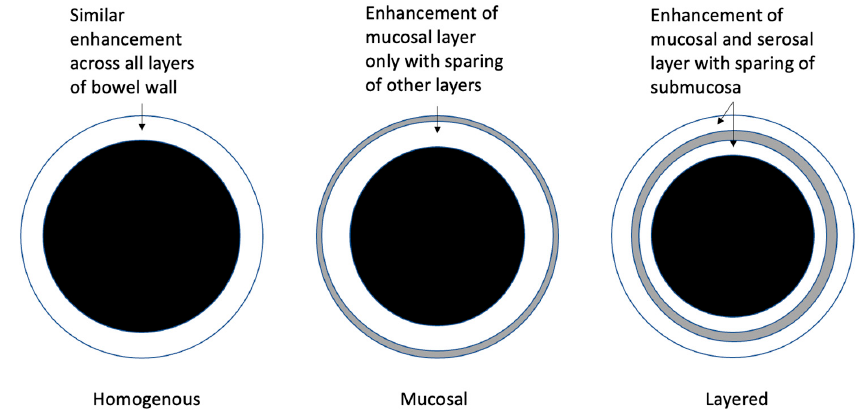
Figure 4. Categories of bowel wall enhancement.